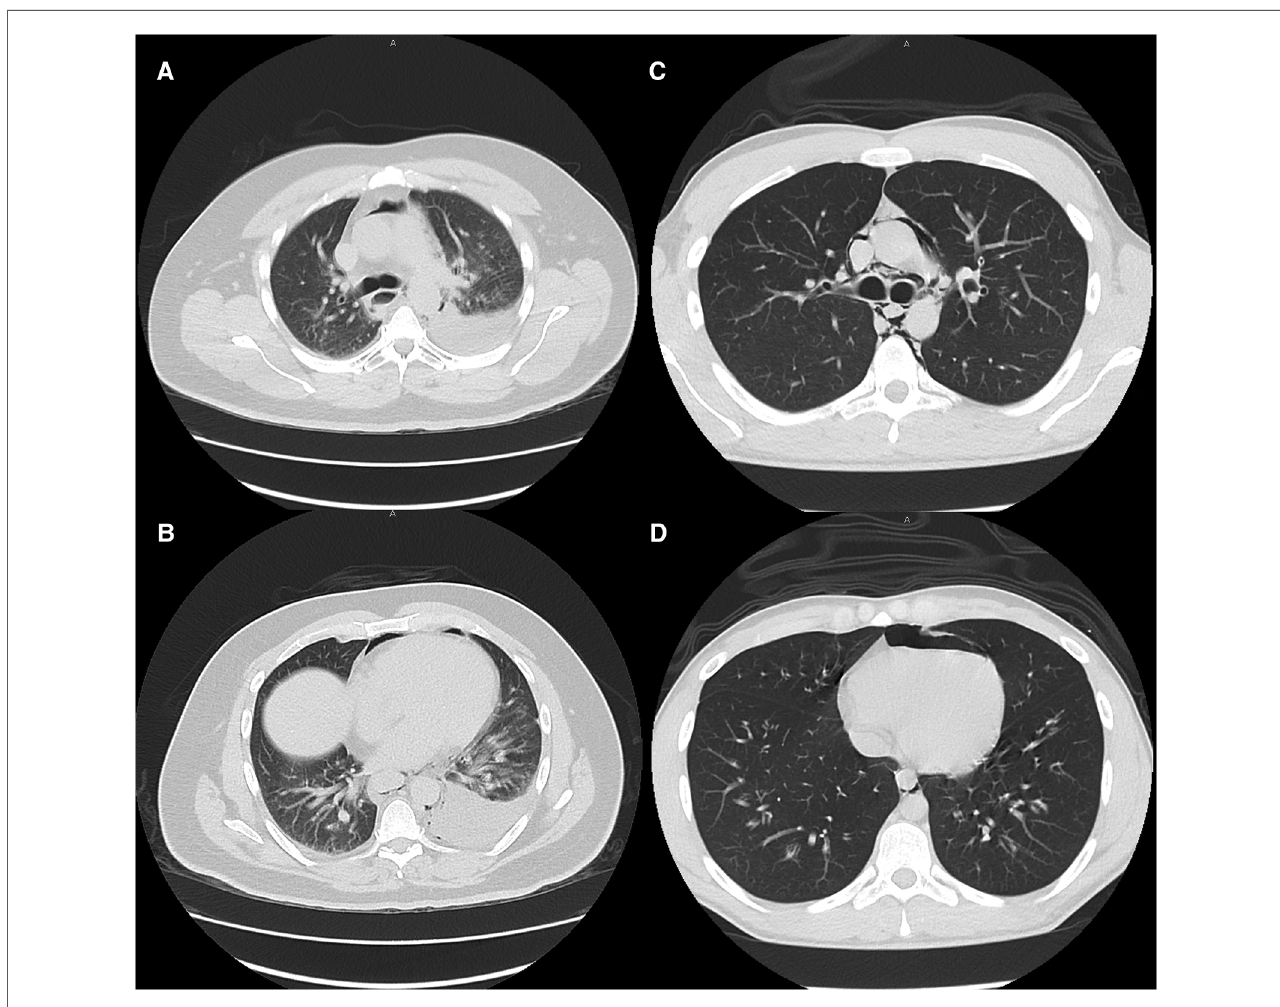
FIGURE 2 Typical CT scan fi ndings of esophageal perforation (patient 13, images A and B ) and marijuana-associated pneumomediastinum (patient 27, images C and D ) at similar levels. Moderate to large pleural effusions are typically associated with esophageal perforation. None of the marijuana-associated sPMD patients presented with pleural